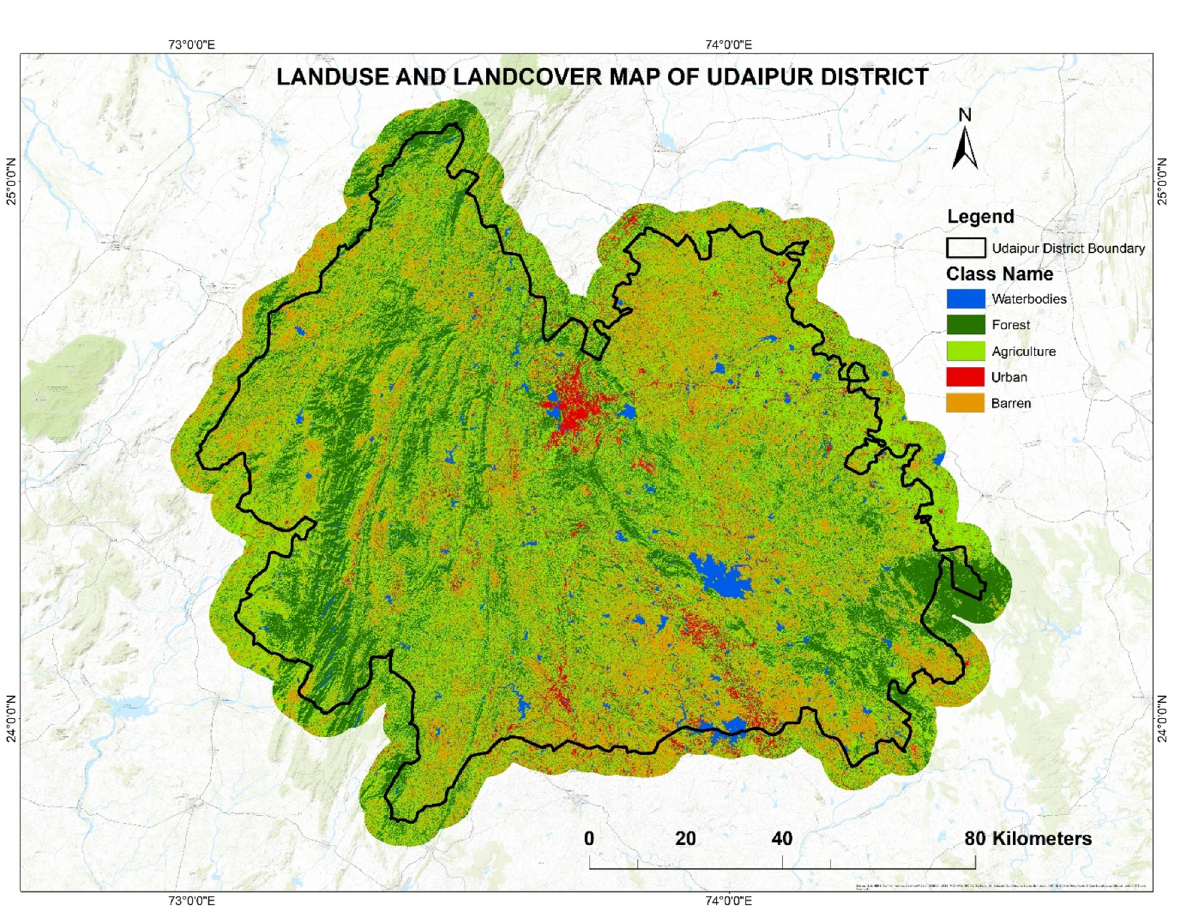
Fig. 4 Land use-land cover classes over the